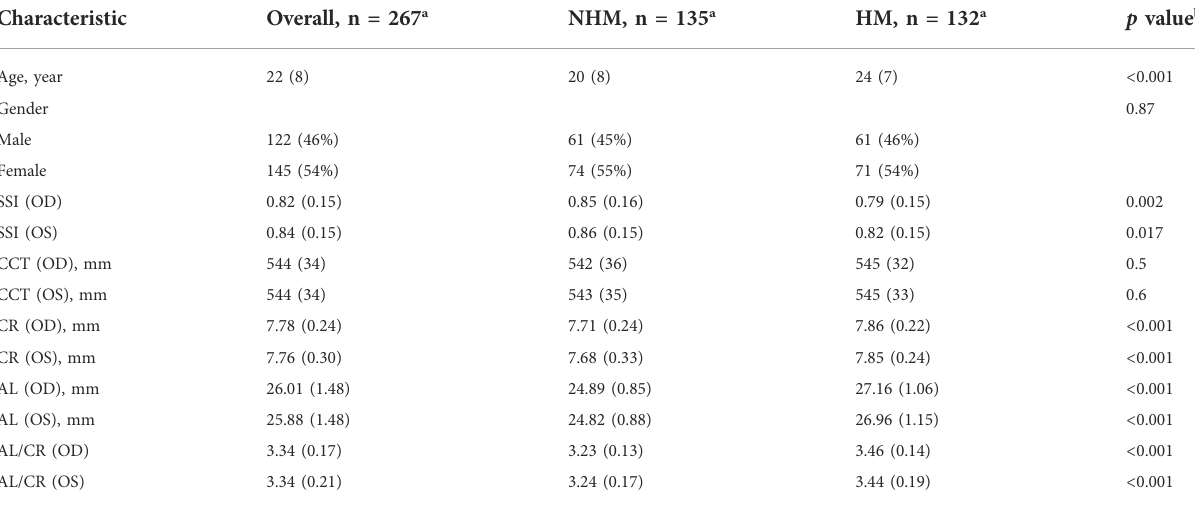
TABLE 1 Participants ’ characteristics of two groups.